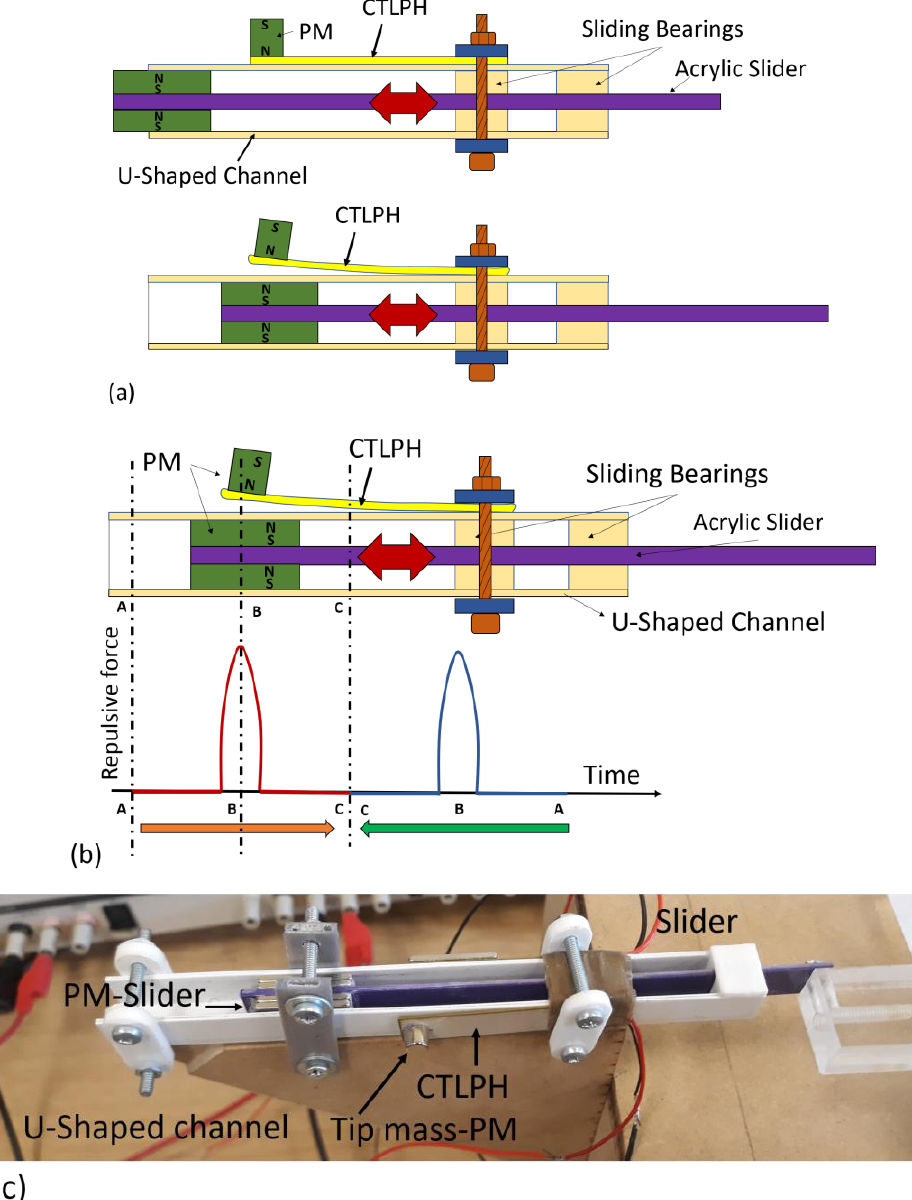
Figure 1. The CTLPH ( a ) A schematic, ( b ) bending deflection in a reciprocating motion, and ( c ) a real mechanism.